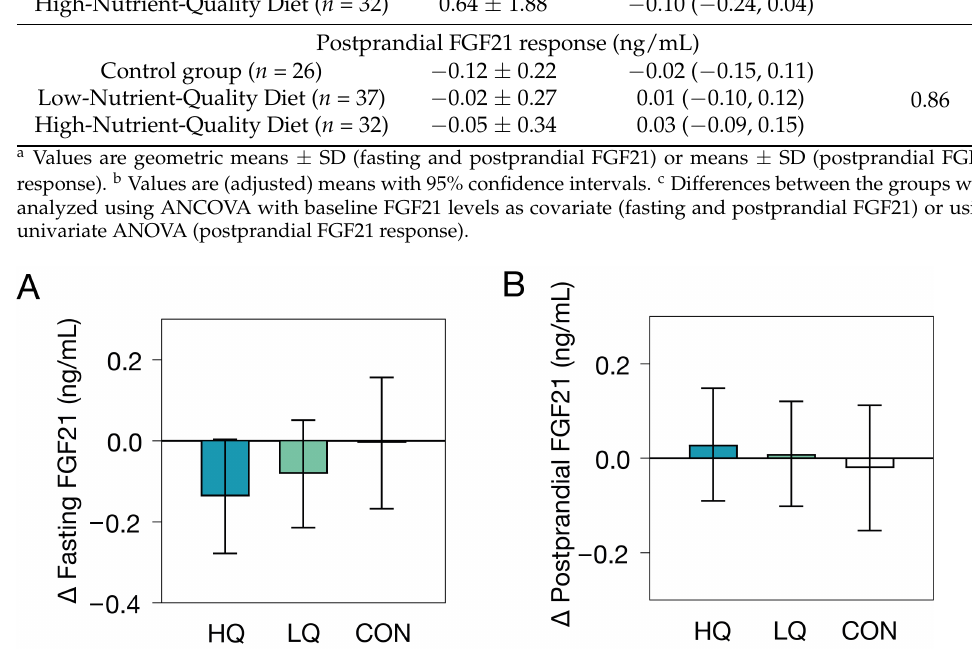
Figure 1. Effects of two 12-week energy restriction diets (HQ, high-nutrient-quality diet; LQ, low- nutrient-quality diet) or control group (CON) on fasting and postprandial plasma FGF21 levels. ( A ) Geometric mean (95% CI) change in fasting plasma FGF21 upon a 12-week diet, as tested by ANCOVA with adjustment for baseline fasting FGF21 levels. ( B ) Geometric mean (95% CI) change in postprandial FGF21 response ( ∆ 120–0 min) to a mixed meal upon a 12-week diet, as tested by univariate